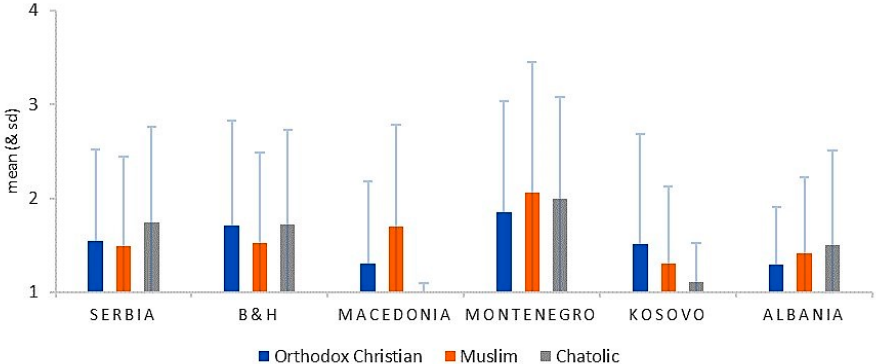
Figure 18. Evading taxes by confession and country. (The error bars represent standard deviation).